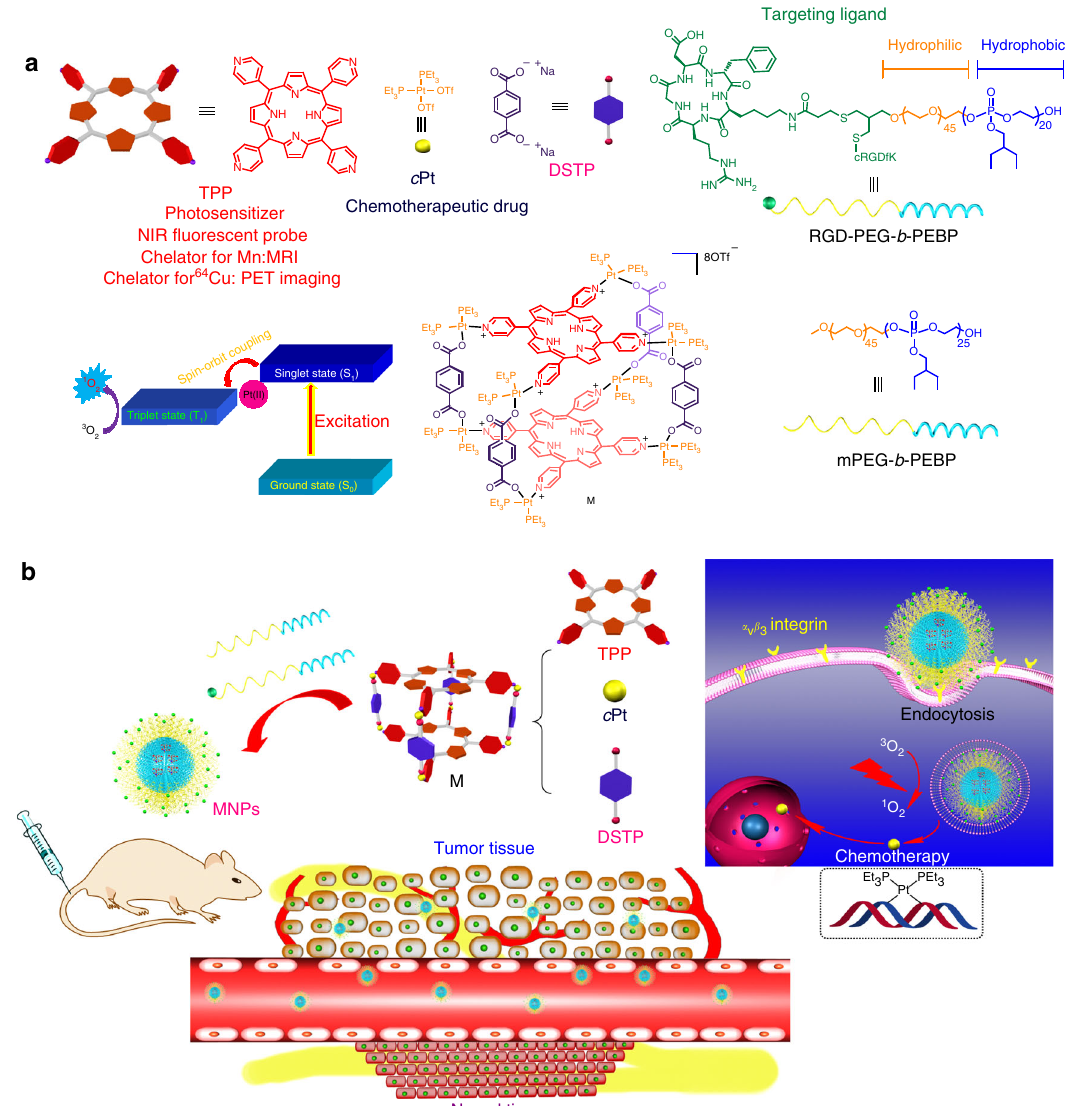
Fig. 1 Schematic diagrams of the MNPs serving as a multifunctional theranostic platform. a Structures of TPP, c Pt, DSTP, M, mPEG- b -PEBP, and RGD-PEG- b -PEBP. b Schematic illustration of MNPs accumulation in tumor tissue followed by EPR effect and receptor-mediated endocytosis, and their applications in subcutaneous (U87MG), drug-resistant (A2780CIS), orthotopic (4T1 and LM3) tumor treatments, and under the same condition, suggesting a high photosensitizing ef fi cacy (Fig. 2f and Supplementary Figure 17). When the well- known 1 O 2 scavenger sodium azide (NaN 3 ) was added, the fl uorescence changes at 532 nm were inhibited, further con fi rm- ing the production of 1 O 2 during laser irradiation (Fig. 2g). By